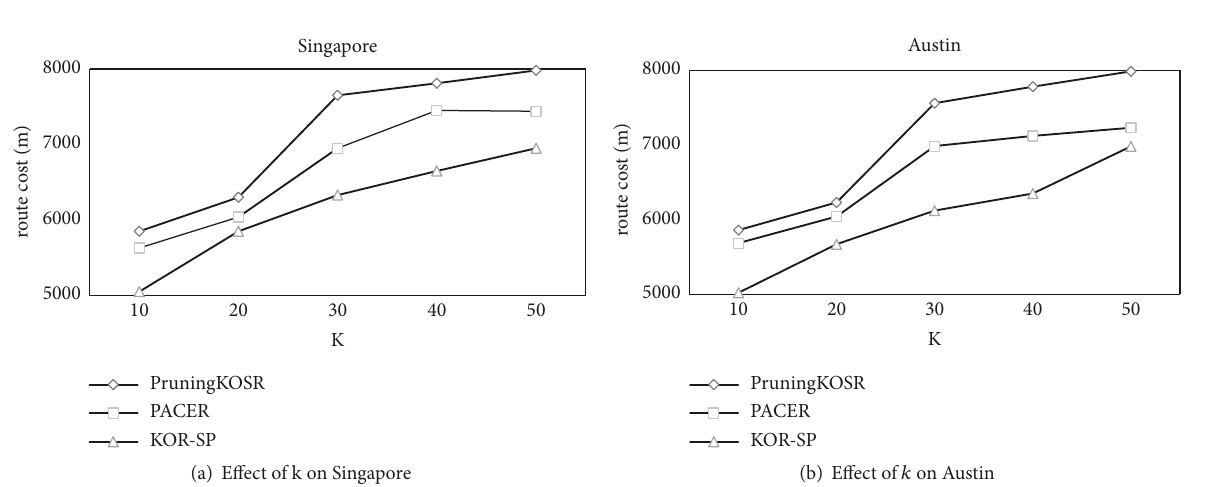
Figure 9: NN queries vs. k .